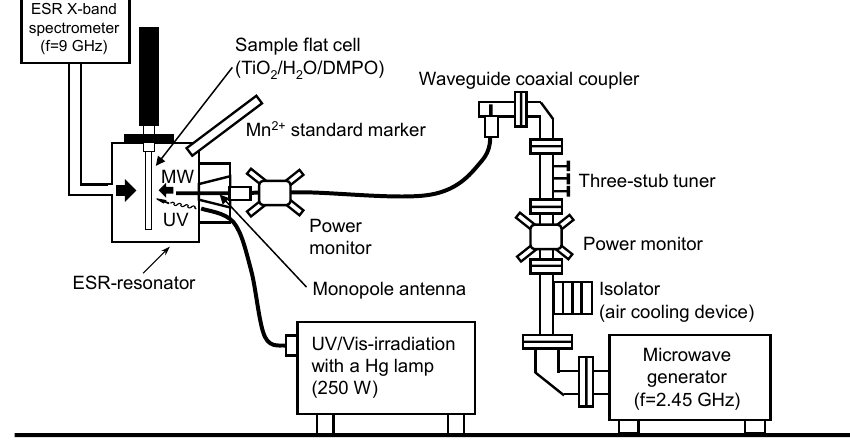
Figure 7. Setup used to generate • OH radicals in water alone under MW irradiation, in an aqueous TiO 2 dispersion by MW irradiation alone, and by the UV and UV/MW methods. Reproduced from [43]. Copyright 2003 by Elsevier